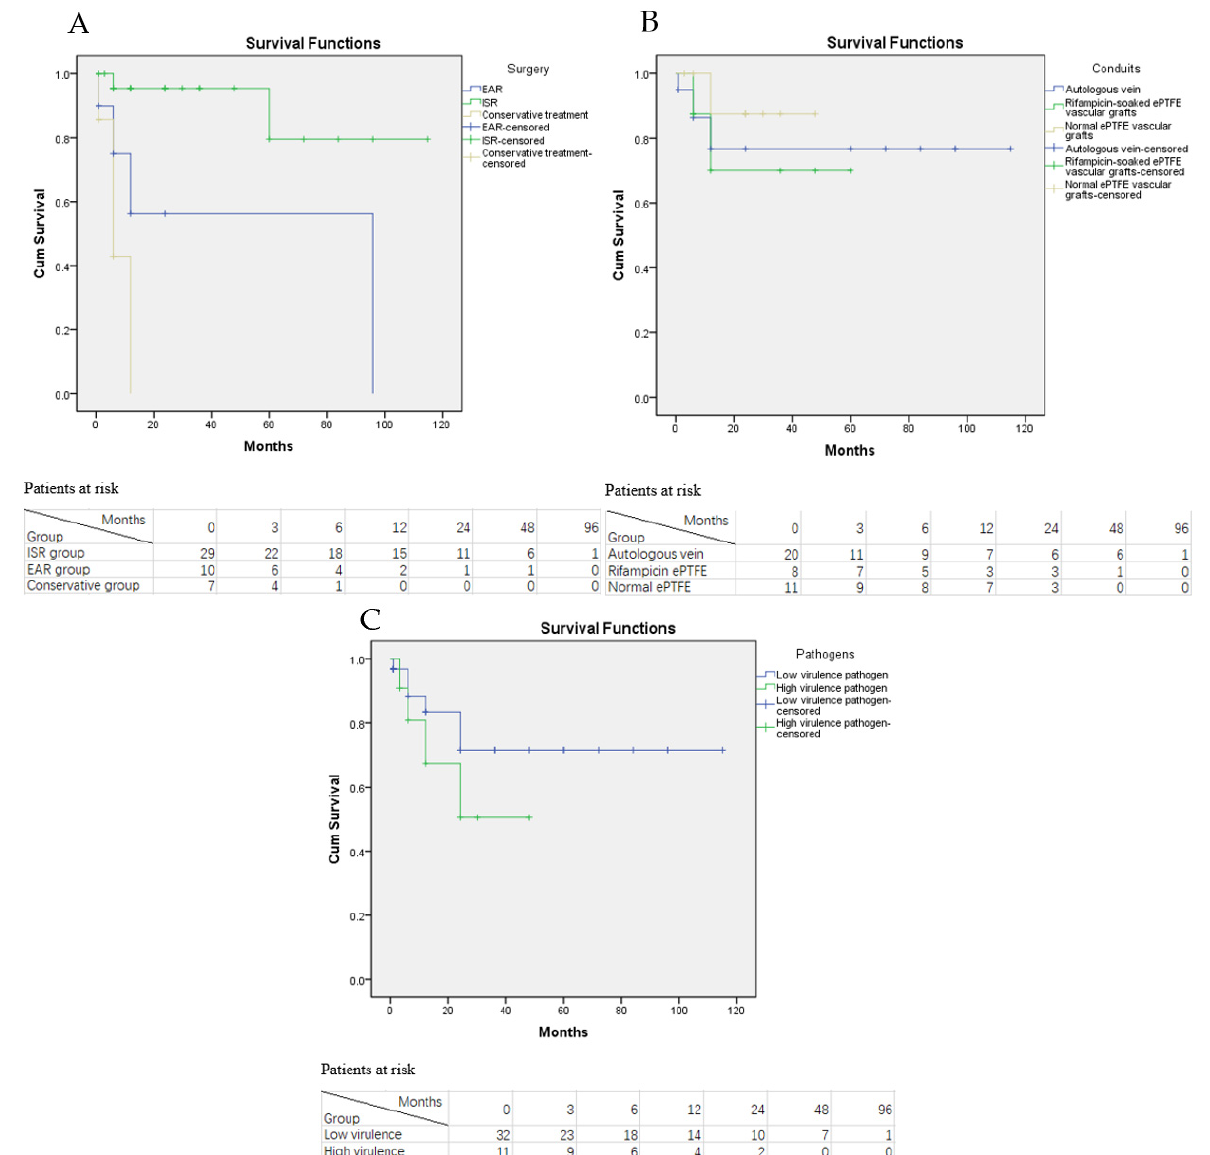
Figure 4. Kaplan-Meier curve of the RI rate in AGI patients. ( A ) KM curve of the RI rate grouped by treatment option with the numbers of patients at risk; ( B ) KM curve of the RI rate grouped by bypass graft conduits with the numbers of patients at risk; ( C ) KM curve of the RI rate grouped by the virulence of infected pathogens with the numbers of patients at risk.